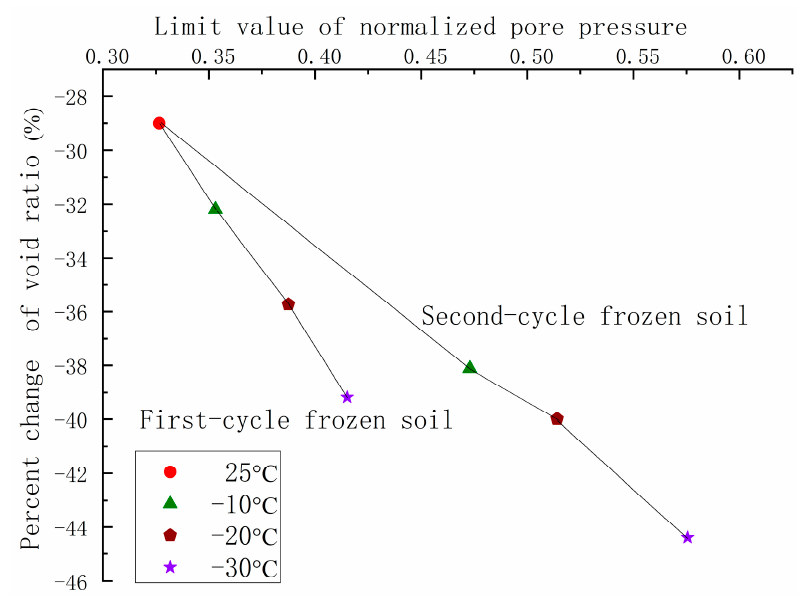
Figure 22. Percentage change of the void ratio curve vs. limit value of normalized pore pressure.